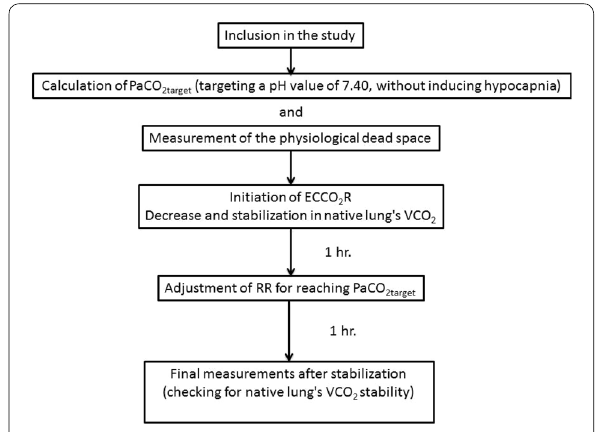
Fig. 1 Flowchart of the study. PaCO 2target : PaCO 2 corresponding to a pH value of 7.40, based on the Henderson‑Hasselbach equation, governing the relationship between the PaCO 2 , pH and bicarbonates plasma values. In cases of mixed respiratory and metabolic acidosis, a PaCO 2target value of 40 mmHg was retained. RR: respiratory